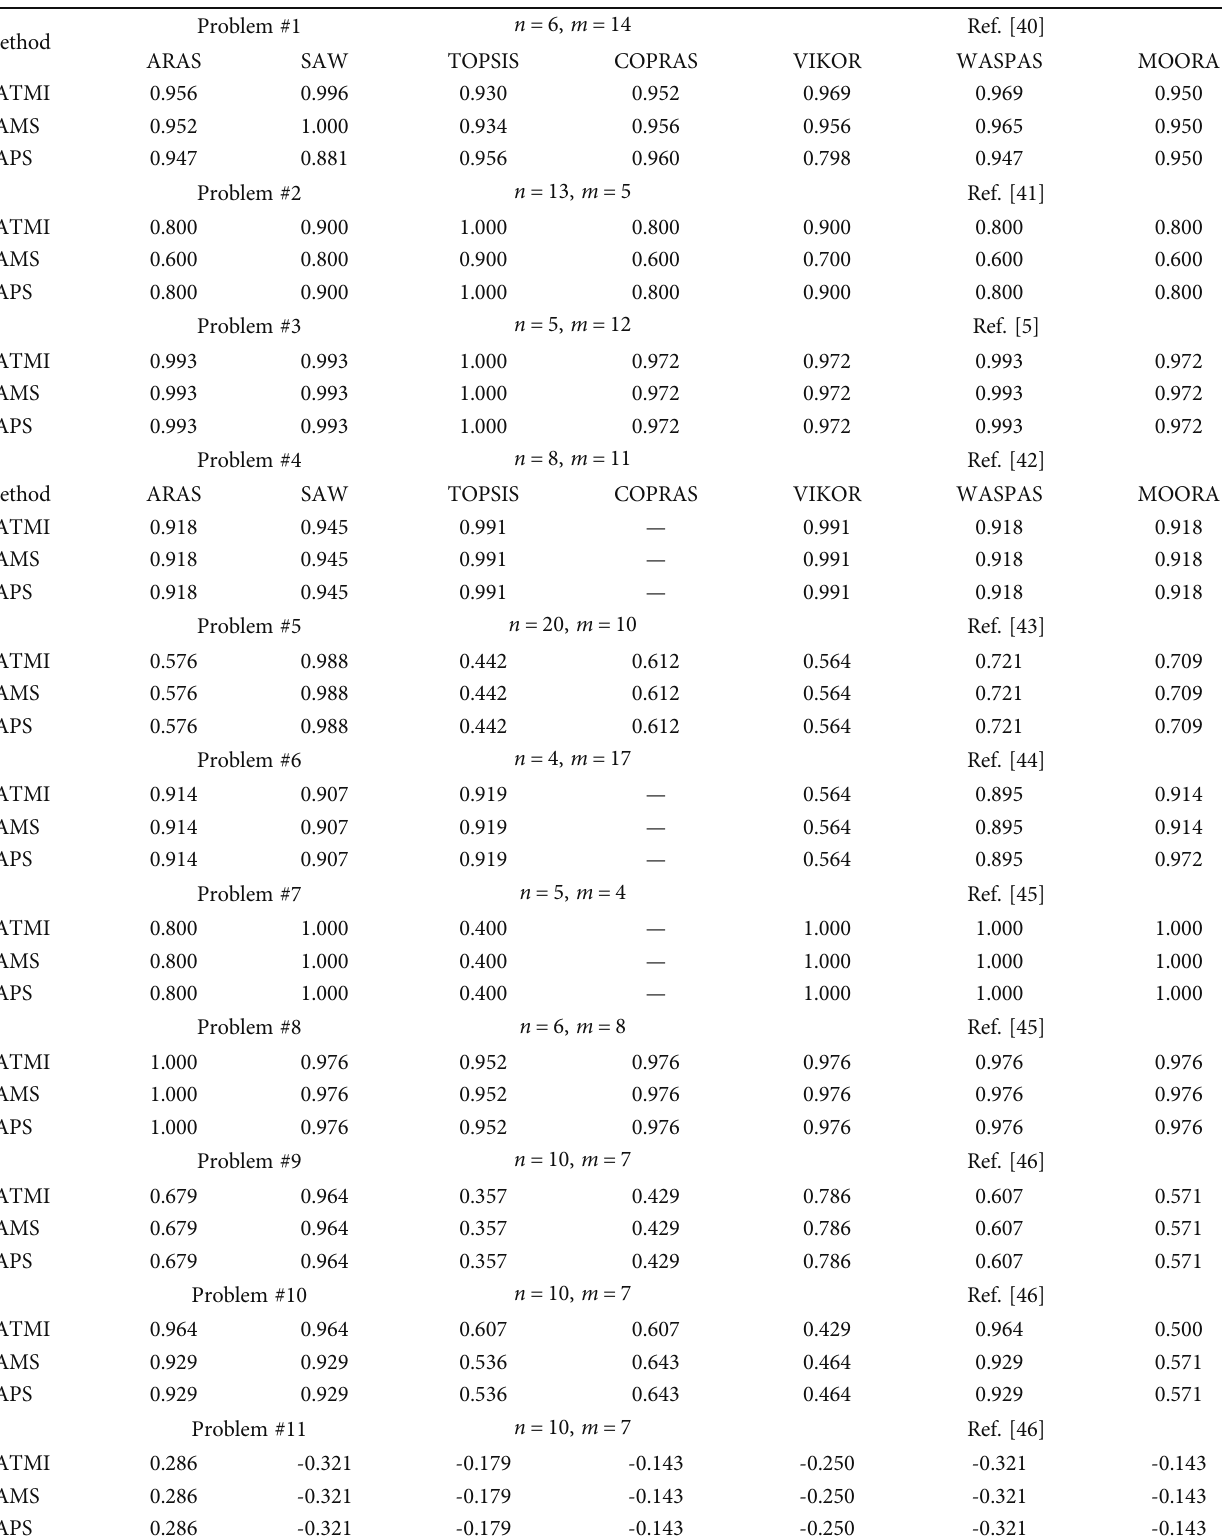
Table 13: Comparative results between the two new techniques RAMS and RATMI and the original technique RAPS with the other seven MCDM